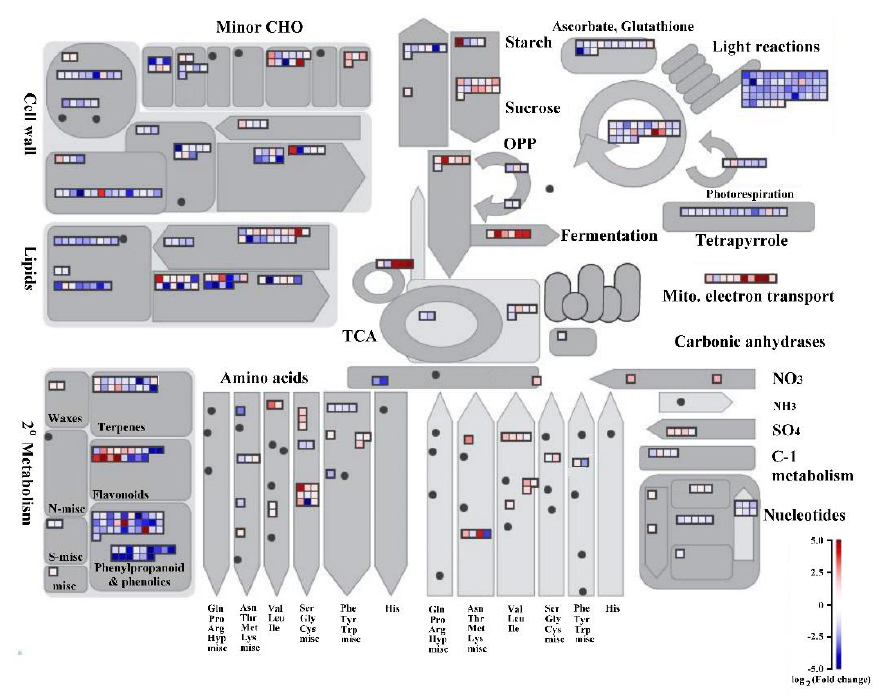
Figure 3. Metabolism overview of differentially expressed genes between submergence treatment and submergence treatment with polar auxin transport inhibitor in coleoptiles, illustrated using MapMan. The log2 fold change (FC) color scale ranges from −5 to 5. Red and blue squares represent up- and down-regulated responses in coleoptiles under SUB + TIBA when compared with SUB only. Minor carbohydrate (Minor CHO), Miscellaneous enzyme (Misc), Oxidative pentose phosphate (OPP), Citric acid (TCA), One carbon metabolism (C-1 metabolism). Table S4 presents the complete list of genes and calculated FC.